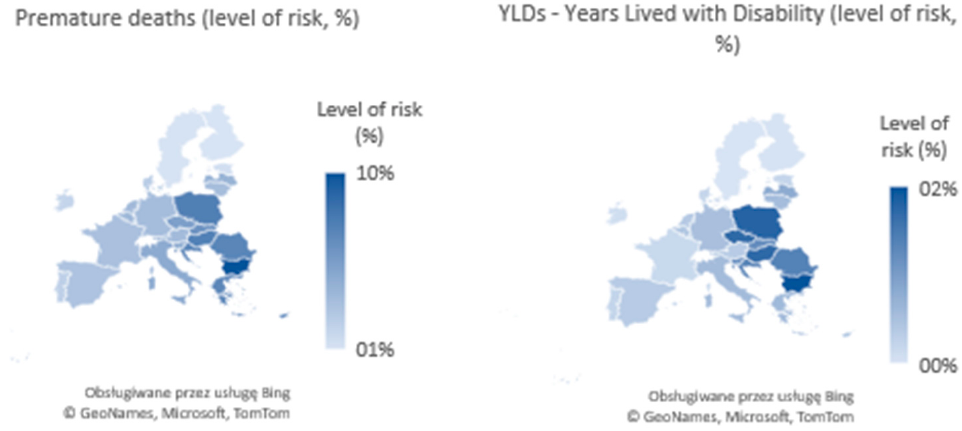
Figure 2. Spatial distribution of the level of risk of air pollution impact on specific consequences of chronic diseases, population aged 20–54 (EU-27 Member States, in 2019).